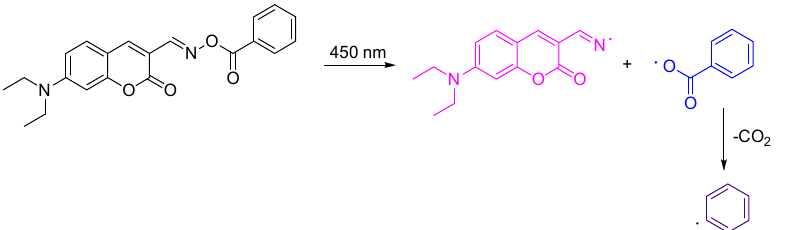
Scheme 3. Mechanism of photocleavage occurring from oxime esters and exemplified for OEC.